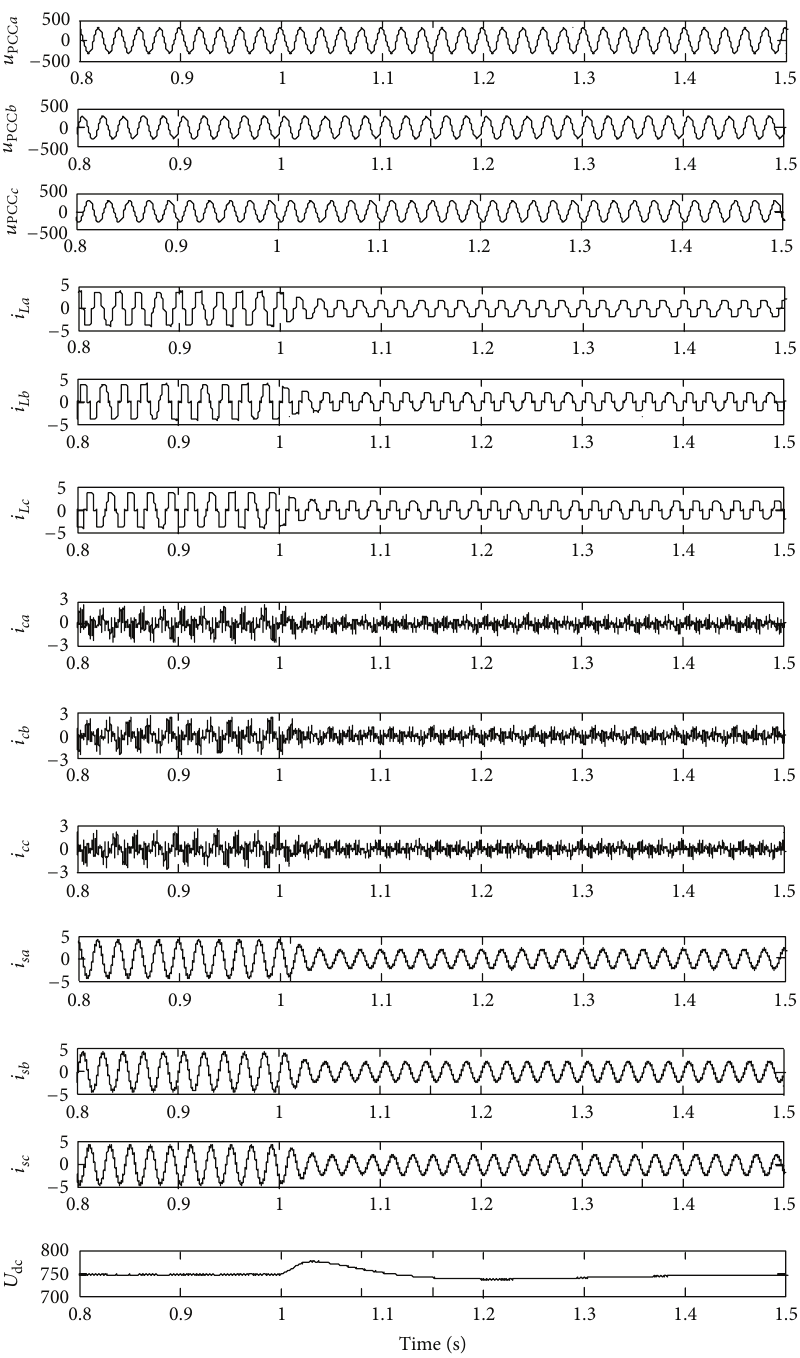
Figure 26: The simulation results for dynamic load